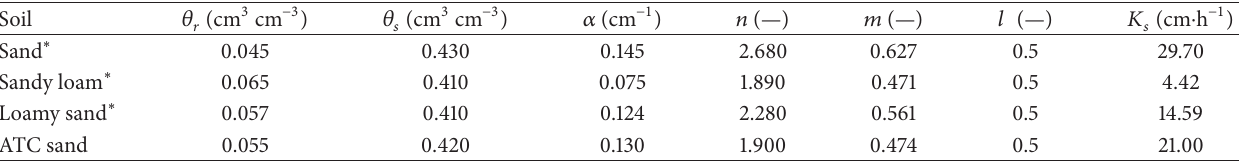
Figure 3: Calibration results of tensiometers: (a) 𝑇 1 and (b) 𝑇 2 expressed as suction pressure, 𝑃 𝑠 , versus voltage from the transducers, 𝑉 𝑡 , using a vacuum pump (circles) and a negative water head pressure (squares) applied at the bottom boundary. Table 1: Soil hydraulic parameters for different soils used to estimate the soil hydraulic functions according to the formulation of van Genuchten [17] (Figure 5).